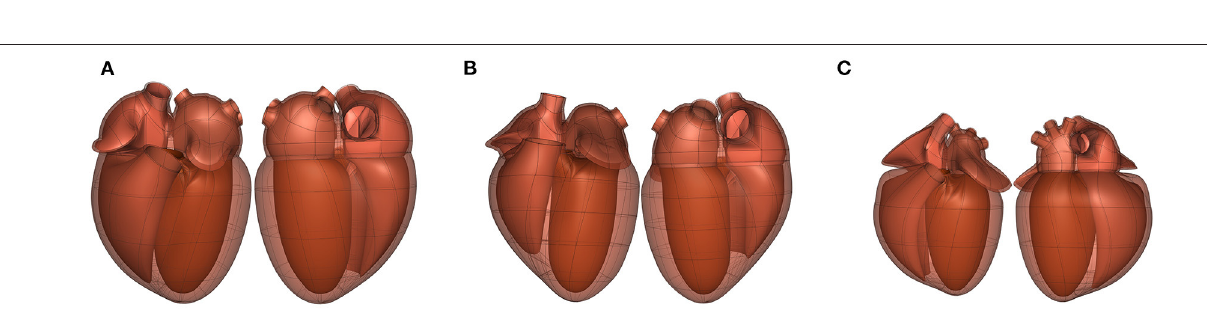
FIGURE 6 | Scaffolds for the colon in the human (dataset available from https://sparc.science/datasets/95), pig (dataset available from https://sparc.science/datasets/98), and mouse (dataset available from https://sparc.science/datasets/76). The scaffolds for each species are built in three steps: (A–C) define a sub-scaffold that captures the cross-sectional anatomy of the colon for the three species, (D–F) define the centerline of the colon, (G–I) attach these sub-scaffolds sequentially to the centerline to form the final scaffold.